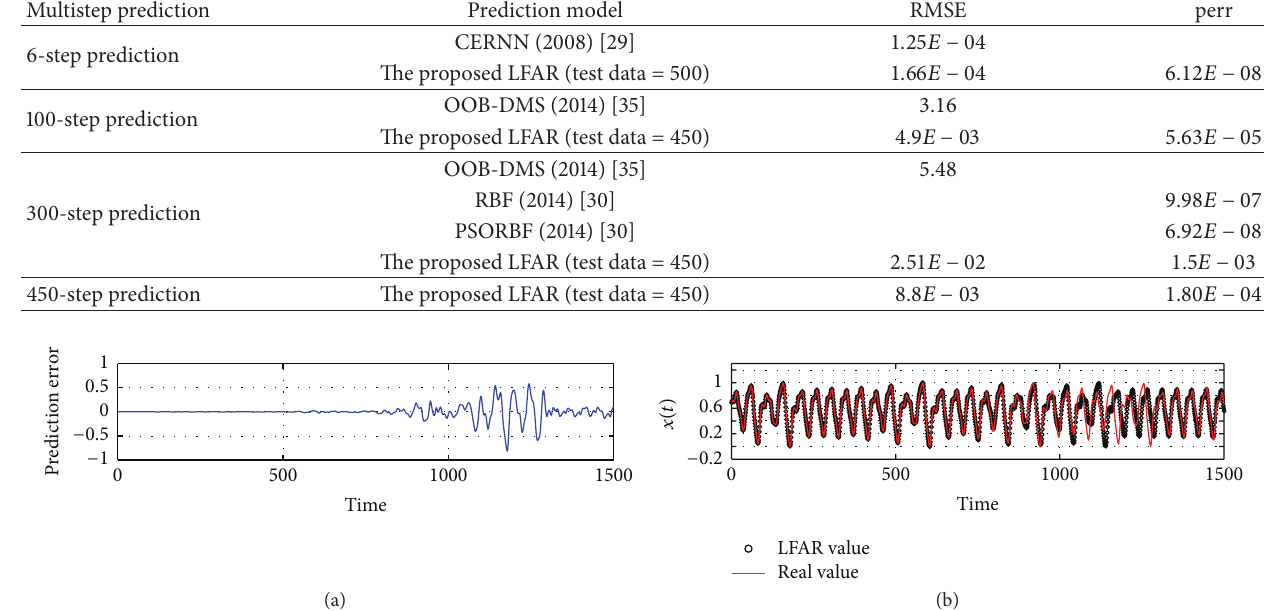
,𝑑 , ℎ ,𝑞 ,𝑚 , 𝜏 ) = (4, 5, 1.1093, 101, 6,7) ). opt opt opt opt opt opt